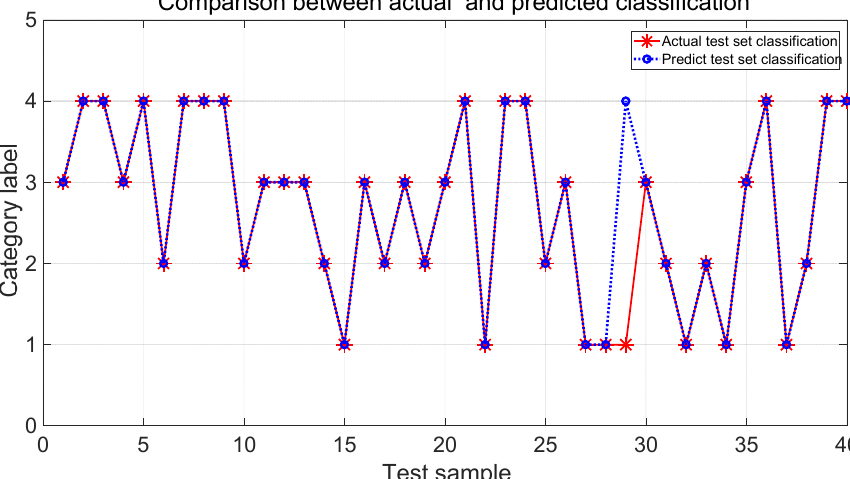
Figure 9. Classification observation based on SVM model.